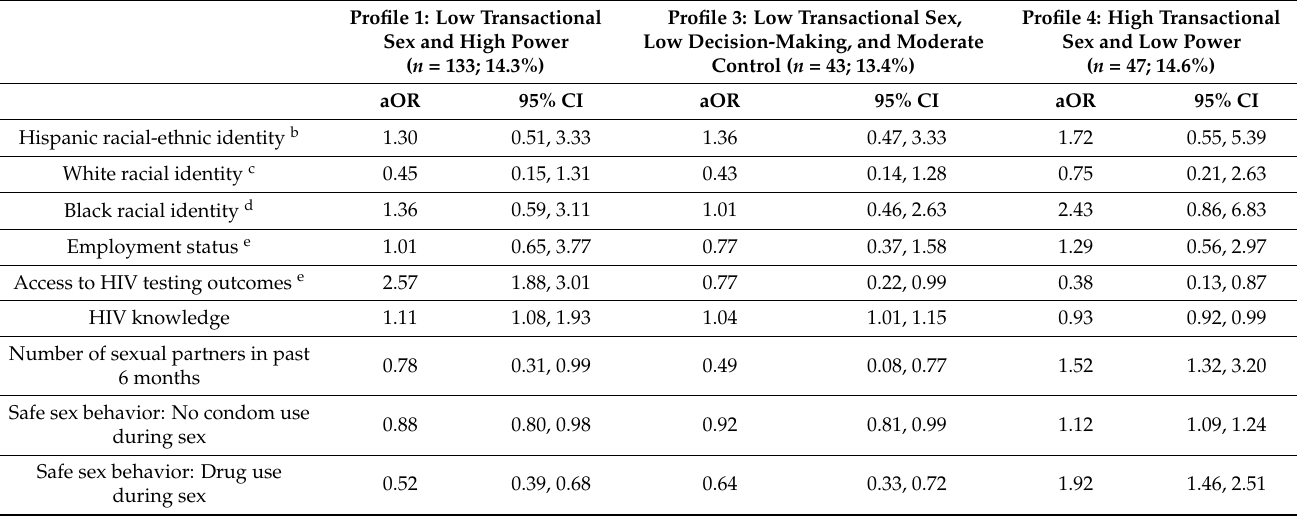
Table 5. Multinomial logistic regression model assessing factors associated with latent profile group membership among MSM participants ( N = 322) a